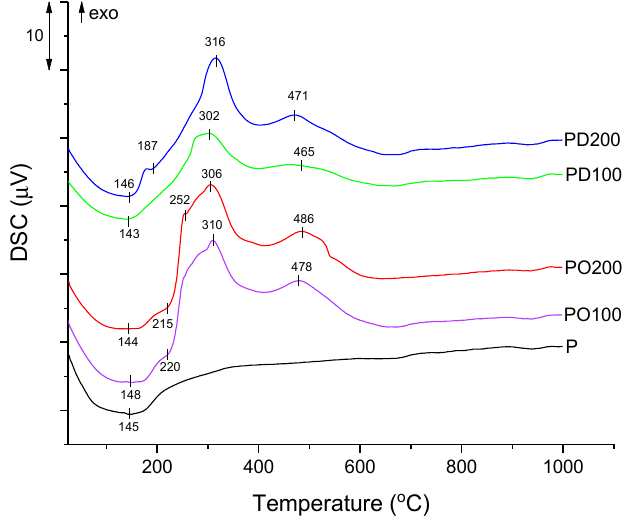
Table 1. Mass loss (%) from TGA curves for starting material-P and composites.